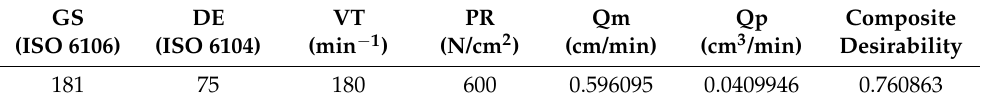
Table 4. Multi-objective optimization considering that Qm is preponderant.